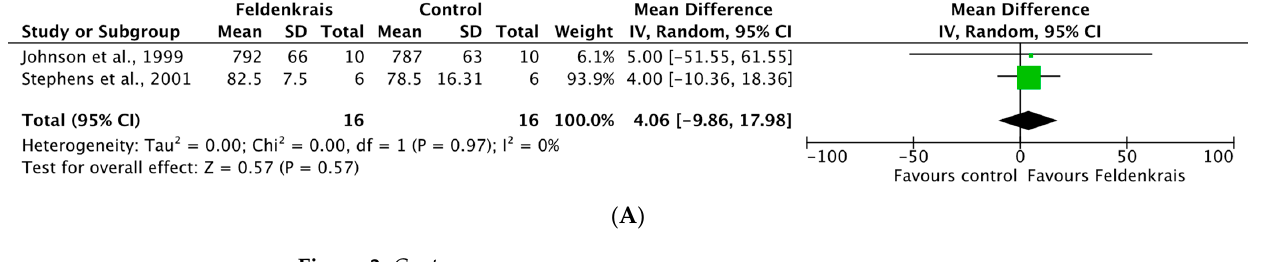
Figure 3. ( A ) Meta-analysis for the Function dimension of the MSSE scale in subjects with multiple sclerosis. ( B ) Meta-analysis for the Control dimension of the MSSE scale in subjects with multiple sclerosis. (Johnson et al. [22], Stephens et al. [26]). 3.3.5. Subjects with Parkinson’s Disease The effects of FM in subjects with Parkinson’s disease were analyzed in two studies with identical samples and protocol (total number of participants n = 30) [27,28]. The mean age was 61 years. The FG received a total of 50 h of ATM sessions, while the CG received educative sessions. Regarding outcome measures, one of them evaluated the quality of life, depression and cognitive status [27], while the other analyzed balance, mobility, gait speed and strength through functional tests [28]. Both studies showed significant effects on the FG [27,28]. One of them showed significant improvements in quality of life, depression and cognitive status in the FG compared to the CG [27]. The other trial showed that the FG improved significantly in all the variables compared to the CG, whereas in the CG all the values worsened [28]. The Timed-Up-and-Go test showed a reduction in the FG, decreas- ing from 22.27 ± 2.93 to 12.46 ± 0.92 s ( p = 0.003). 3.3.6. Other Populations Quintero et al. [25] investigated the effects of a 30 h ATM sessions protocol on the head posture of 26 children with nocturnal bruxism with a mean age of three to four years. Torres-Unda et al. [21] investigated the effects of a 30 h ATM sessions protocol on the physical function and balance (measured with a stability platform) of middle-aged per- sons with intellectual disabilities, for whom difficulties due to aging appear earlier than in people without intellectual disabilities [21]. Regarding the effects, Quintero et al. [25] showed the efficacy of FM in treating chil- dren with nocturn bruxism, for whom the FM increased the craniovertebral angle and corrected the head posture. In middle-aged persons with intellectual disabilities, Torres- Unda et al. [21] showed a significant improvement in physical function in FG compared to CG and a reduction of the sway area. 4. Discussion This systematic review presents the evidence available to date on the effects of FM in the population eligible for physical therapy treatment. Population groups included el- derly people, people with musculoskeletal pain in the spine or shoulder, and people with neurodegenerative diseases such as MS or PD. In relation to the obtained results, most of the trials showed significant changes in the FG. In elderly subjects, the mean differences obtained in favor of FM in the Timed-Up-